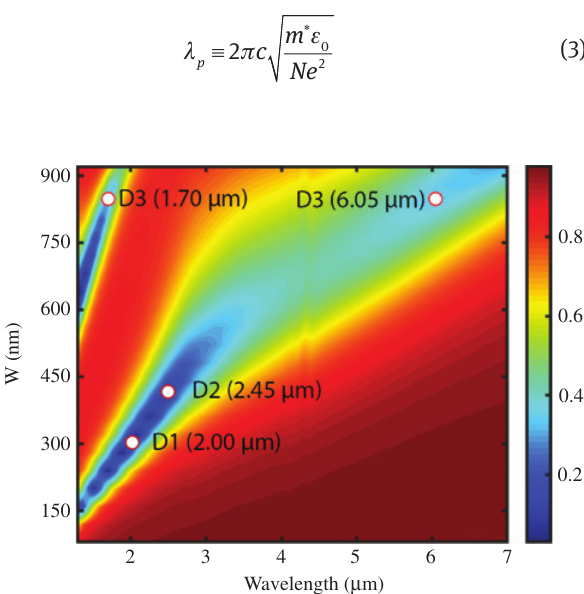
Figure 5: The simulated reflectance spectrum map for a resonator period of 1.0 μ m as a function of wavelength and width of the resonator rod.